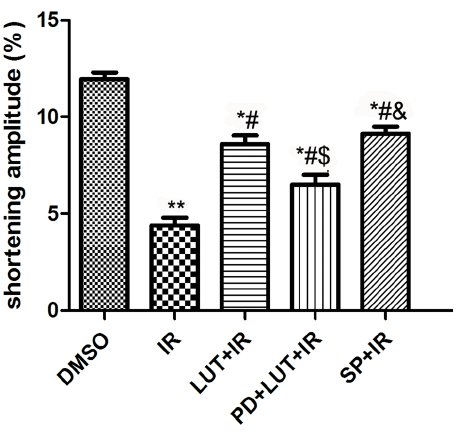
Figure 4. The contractile function of single cardiac cell. Effect of luteolin and SP600125 on shortening amplitude in isolated I/R cardiomyocytes were observered. The results are expressed as the mean 6 SEM, n=3. * P , 0.05, ** P , 0.01 versus DMSO; # P , 0.05 versus I/ R; $ P , 0.05 versus I/R + Lut (8.0 m M), & P , 0.05 versus I/ R + Lut(8.0 m M) + PD(10 m